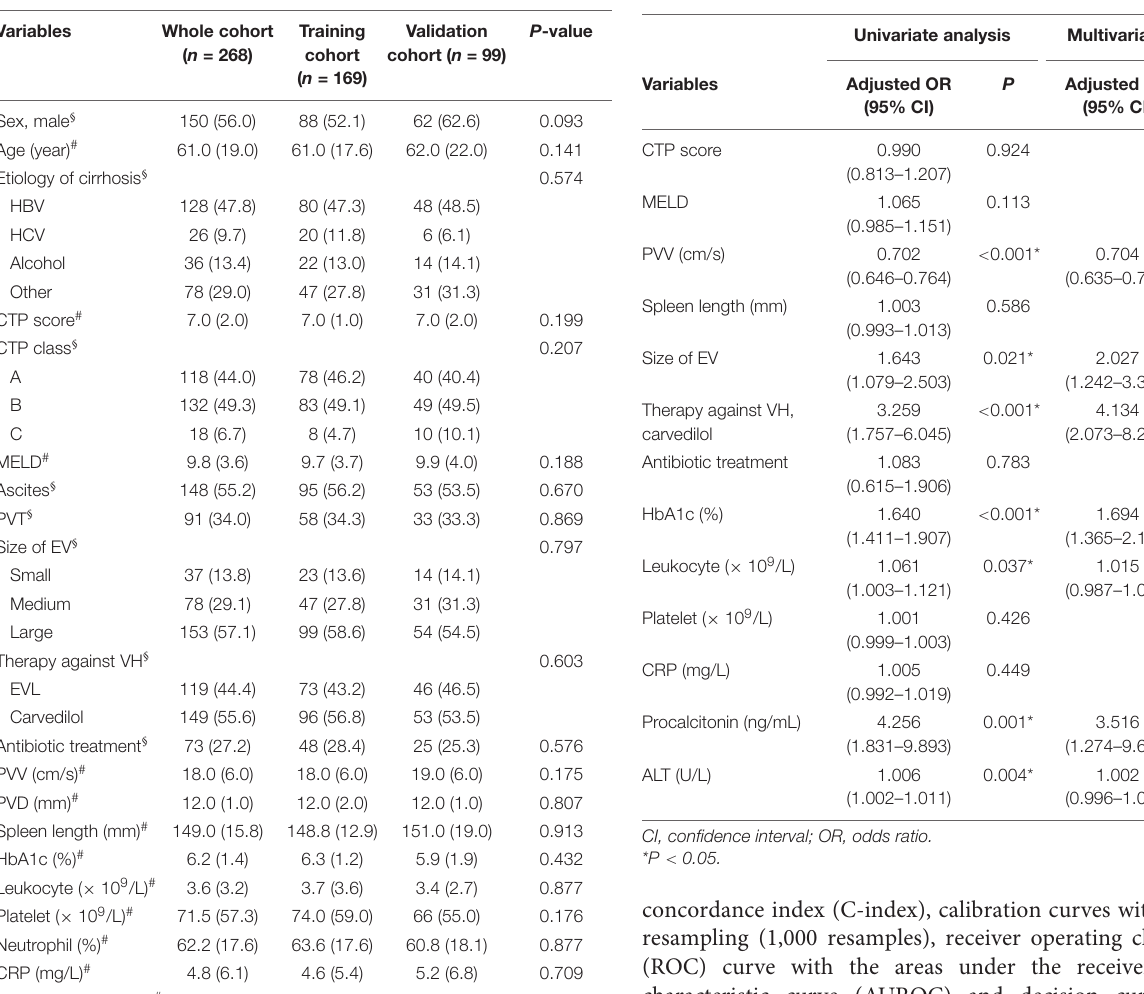
TABLE 2 | Univariate and multivariate Cox regression analyses of the training